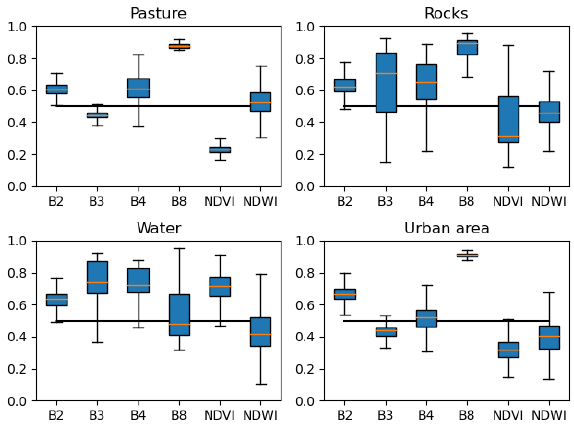
Figure 1. All annotated pixels: box plots of channel weight attention for 4 classes, normalized by class sums. Horizontal lines depict activation thresholds (0.5 for a